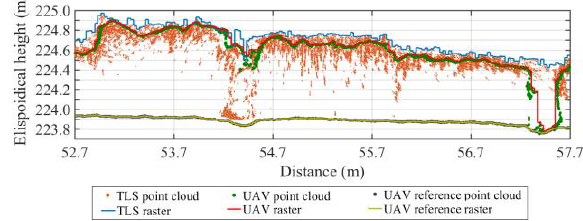
Figure 4. Example of a cross section of canopy height measures derived from UAV and TLS point clouds. The orange points